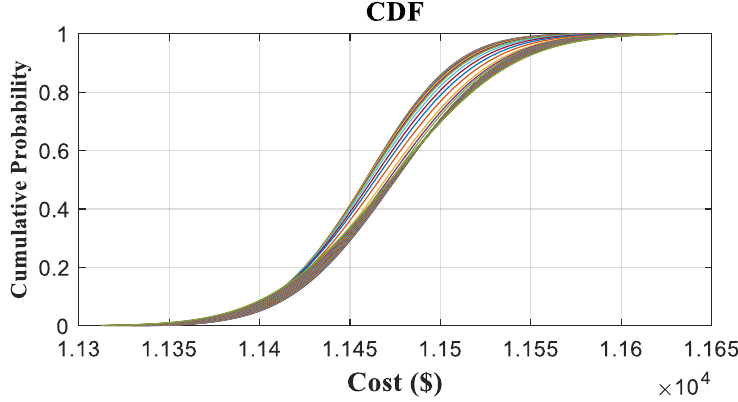
Figure 18. Normalized cumulative distribution function